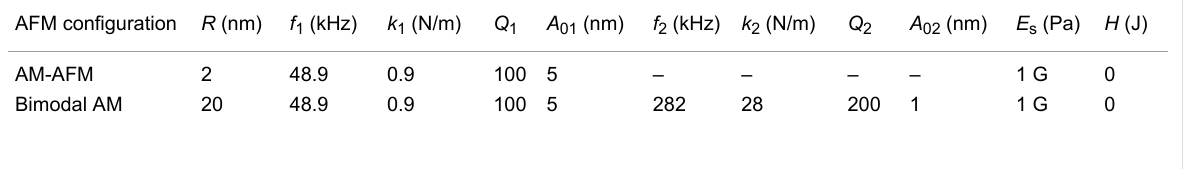
AFM configuration R